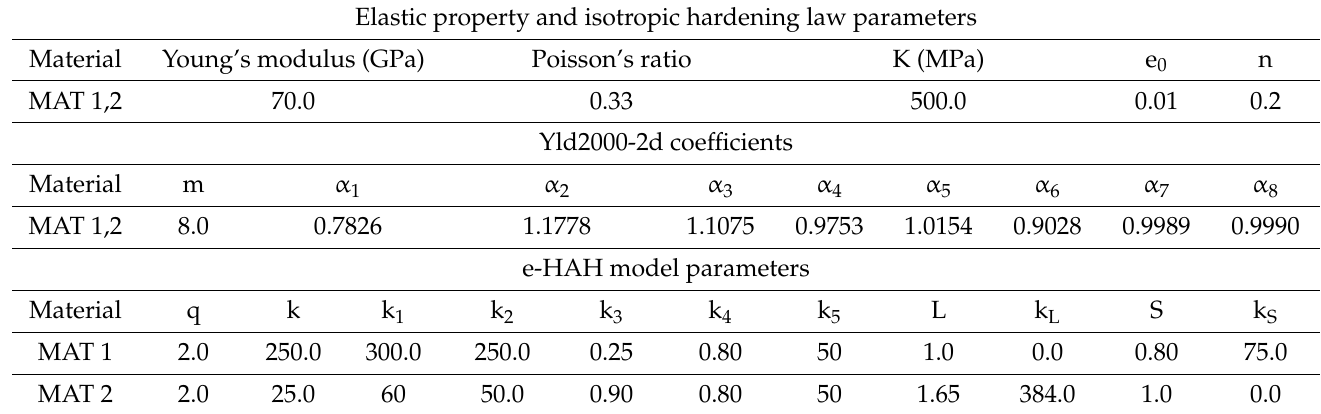
Table 2. Constitutive parameters of isotropic linear elasticity and e-HAH model. Elastic property and isotropic hardening law